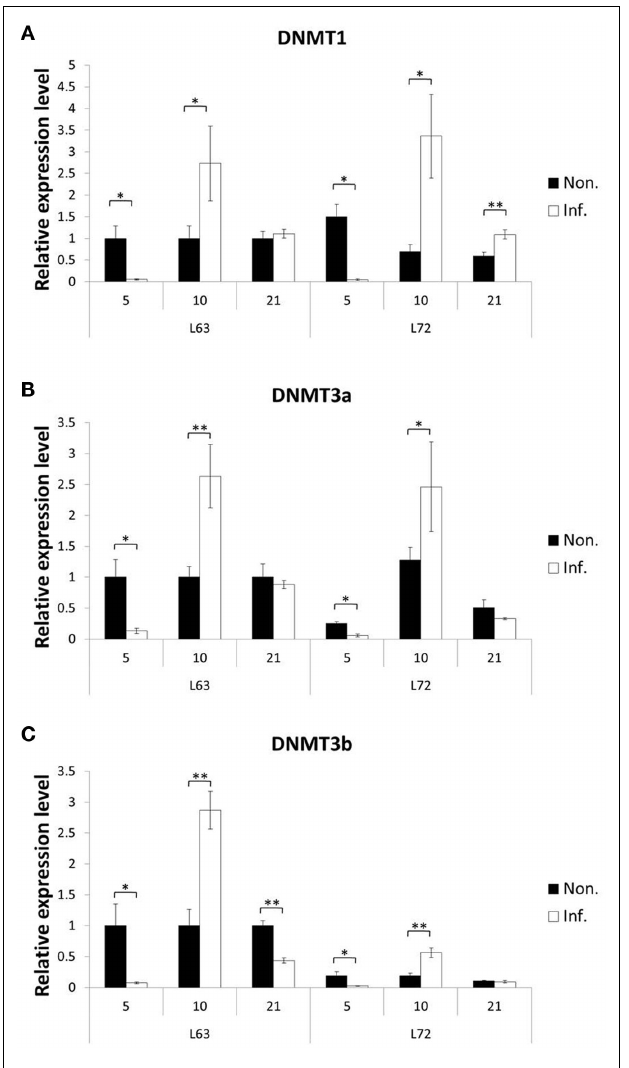
FIGURE 4 | Expression of DNA methyltrasferase genes after MDV infection. The expression of three DNA methyltrasferase genes, DNMT1 (A) , DNMT3a (B) , and DNMT3b (C) , were tested by quantitative real-time RT-PCR at 5, 10, and 21dpi in chicken spleen both resistant and susceptible to MD.The relative expression level was normalized to GAPDH gene. Black: non-infected; white: infected. * P < 0.05, ** P < 0.01. N = 4 for each group. Error bar = SEM.